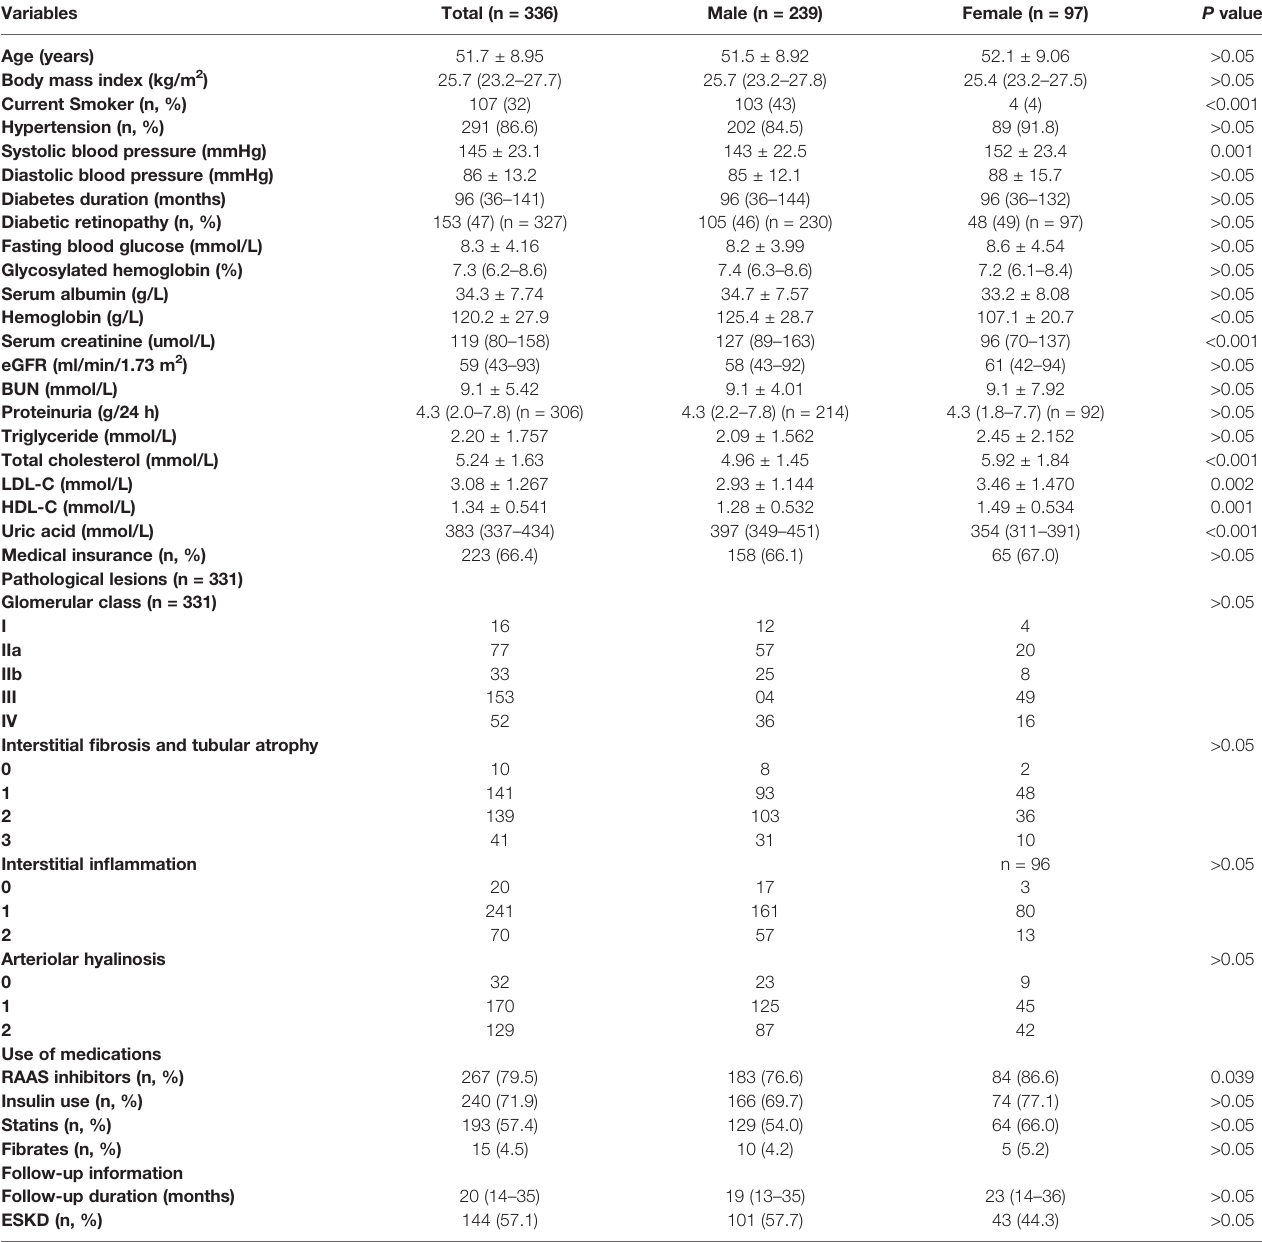
TABLE 1 | Baseline clinicopathological fi ndings in male and female groups.